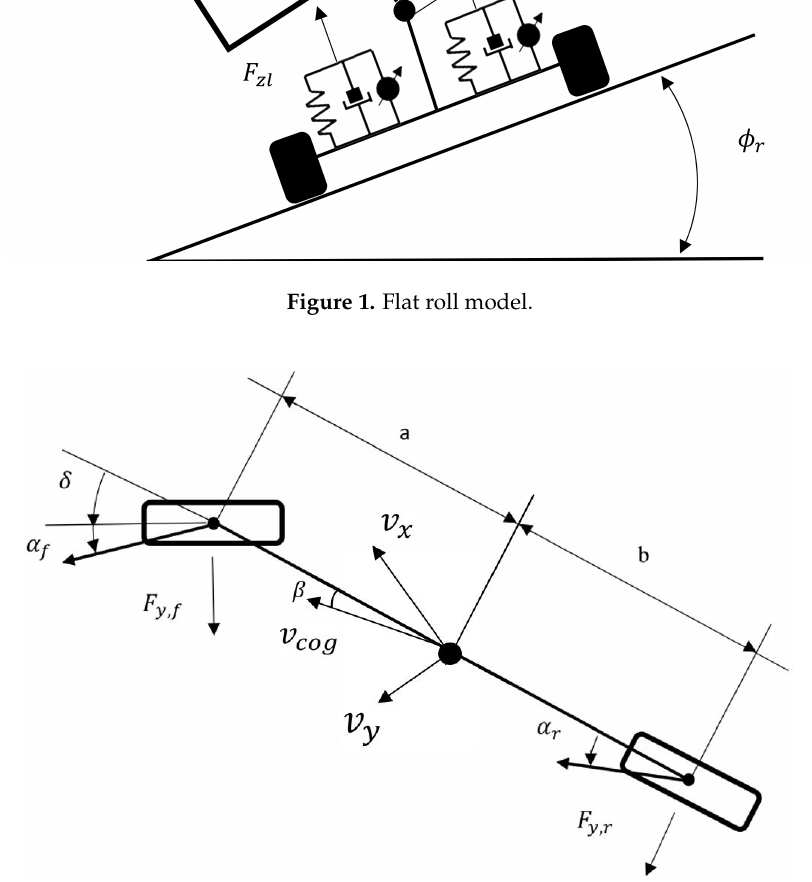
Figure 2. Bike lateral motion